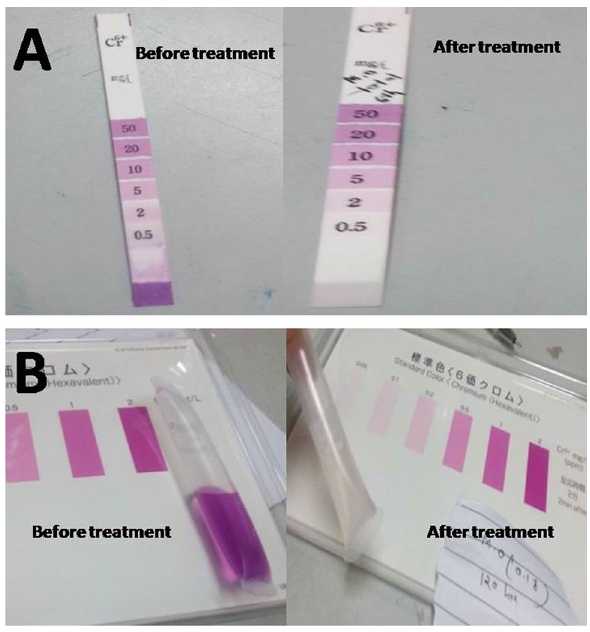
Fig. 3 MSP and WSP treatment in eliminating Cr 6+ from effluent water; color bands mean the presence of Cr + , where transparent color indicates the level of Cr + below detection limit ( a Cr 6+ test strips; b Cr + test